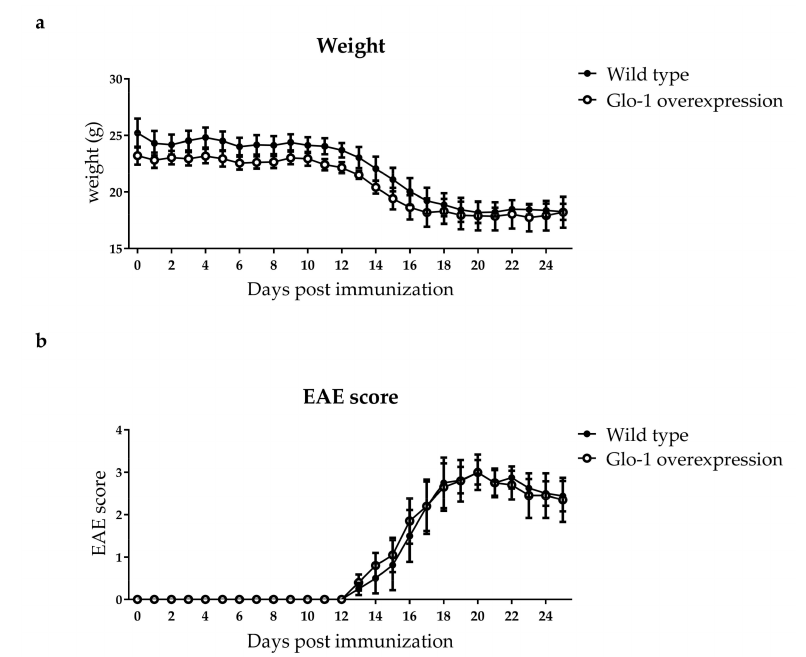
Figure 2. Full body Glo-1 overexpression does not affect EAE disease outcome. Glo-1 overexpression mice and wild type littermates were immunized with MOG to induce EAE. Wild type ( n = 4) and Glo-1 overexpression ( n = 5) mice were weighed ( a ) and scored ( b ) daily for 25 days after EAE induction. Closed circles ( ) represent wild type littermates and open circles ( mice. Data is presented as mean ± SEM and analyzed using two-way ANOVA with Sidak’s multiple comparisons